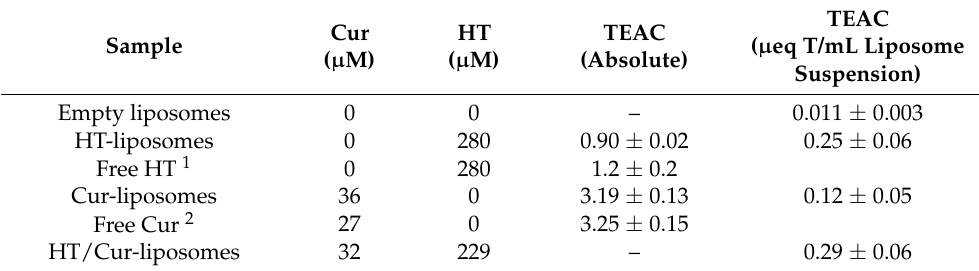
Cur HT TEAC ( µ M) ( µ M) (Absolute)